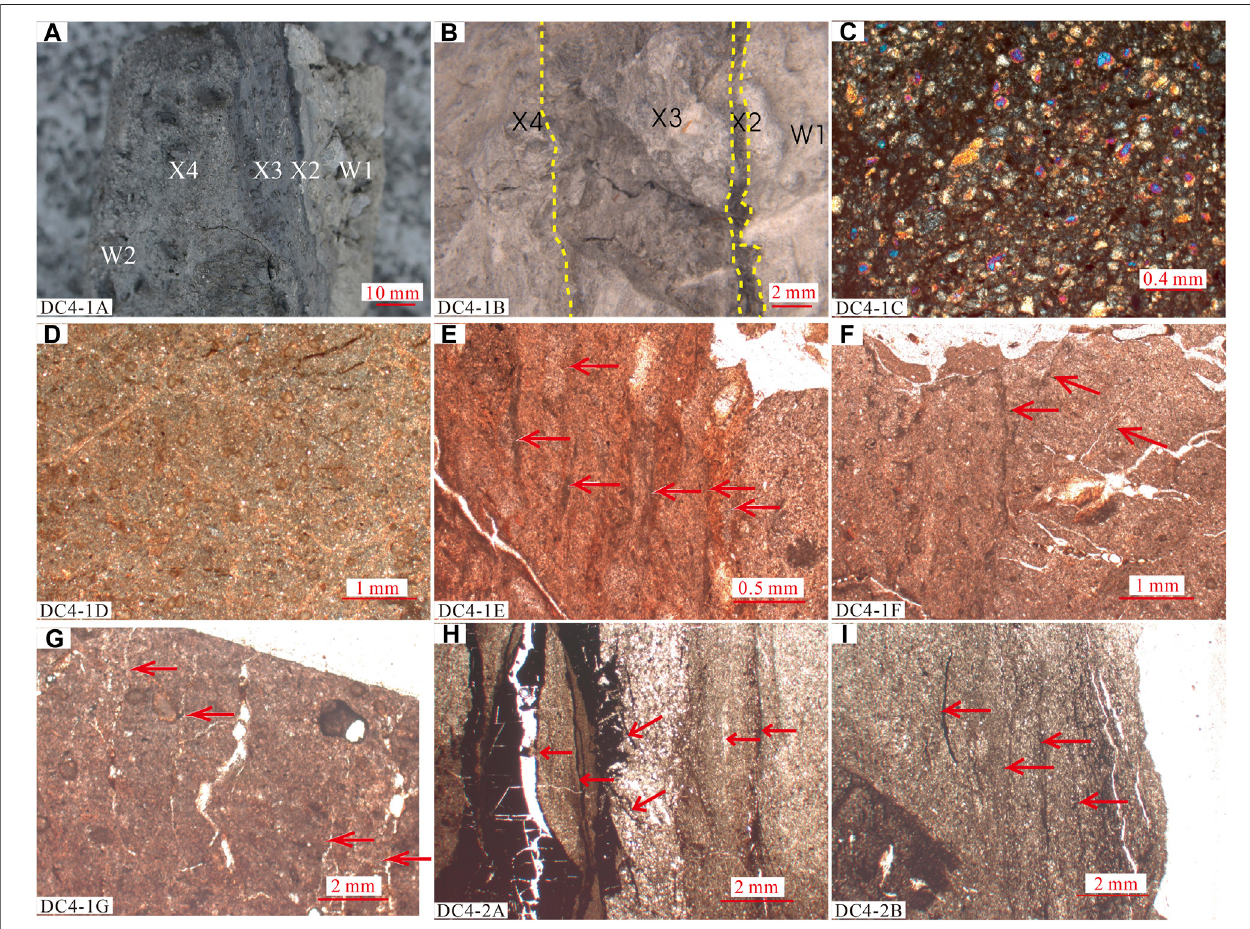
FIGURE 5 | Photographs of sample DC4-1 and DC4-2. (A) Core sample containing fault gouges X2, X3, and X4. W1 and W2 denote the country rock (sandstone and mudstone, respectively) on either side of the gouge. (B) Stereoscopic image showing the fi ne textures of the fault gouge samples X2, X3, and X4. (C,D) Photomicrograph of country rock W1 and W2, respectively, showing the lack of deformation. (E – G) Photomicrographs of sample DC4-1. (H,I) Photomicrographs of sample DC4-2. Arrows show discontinuous fracture cleavage or fi ssures.